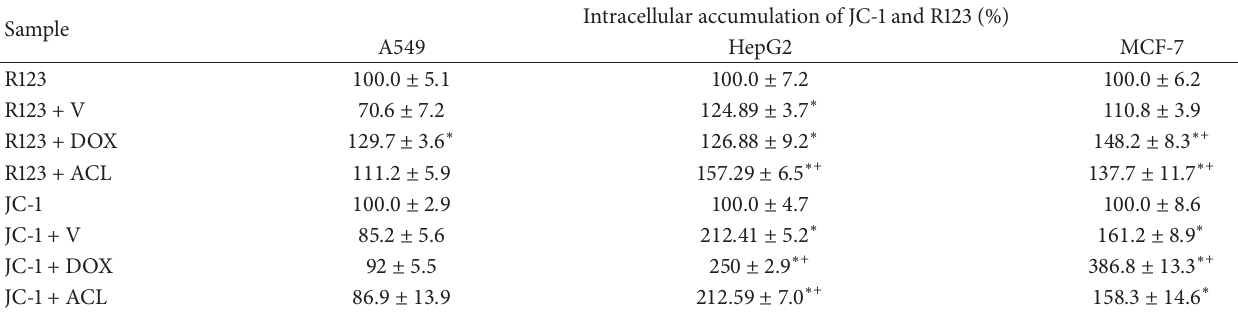
Table 1: Flow cytometry analysis of P-gp functional activity with R123 or JC-1 in A549, HepG2, and MCF-7 cells. Sample